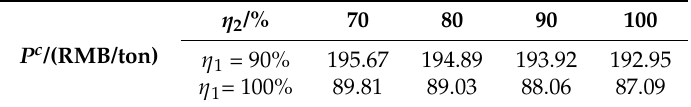
Table 9. Critical carbon prices under different government subsidy